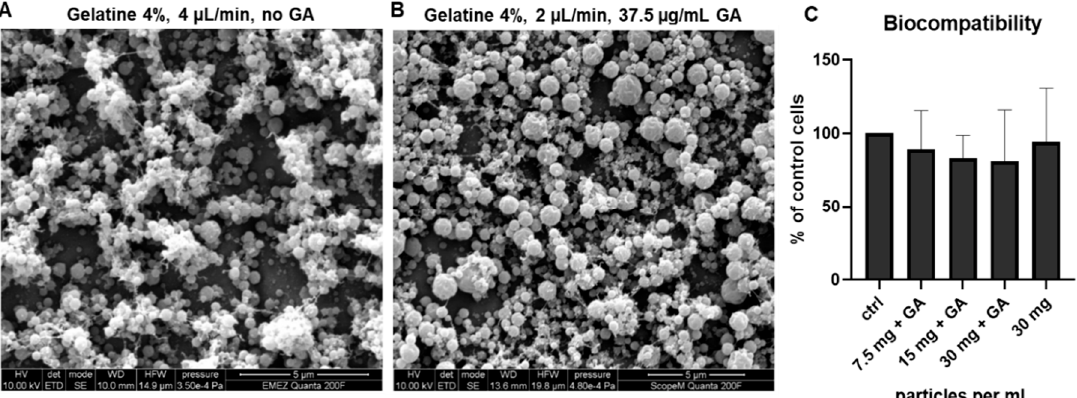
Figure 2. Optimized electrospraying of gelatin microparticles. ( A ) SEM images of plain gelatin particles sprayed with 4% w / v gelatin under 4 µ L / min flow rate ( n = 7 batches). ( B ) SEM images of glutaraldehyde (GA)-crosslinked particles sprayed with 4% w / v gelatin and 37.5 µ g / mL GA under a 2 µ L / min flow rate ( n = 7 batches). ( C ) Biocompatibility of GA–gelatin microparticles after four days of indirect contact with disc cells ( n = 4 donors, Kruskal–Wallis with Dunn’s post hoc test, p < 0.05).